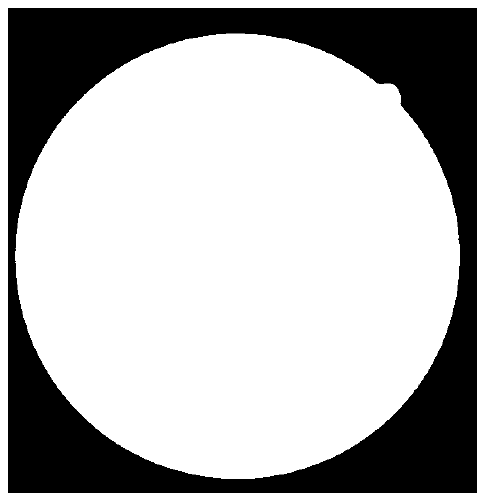
Figure 5. Process area of Figure 2.